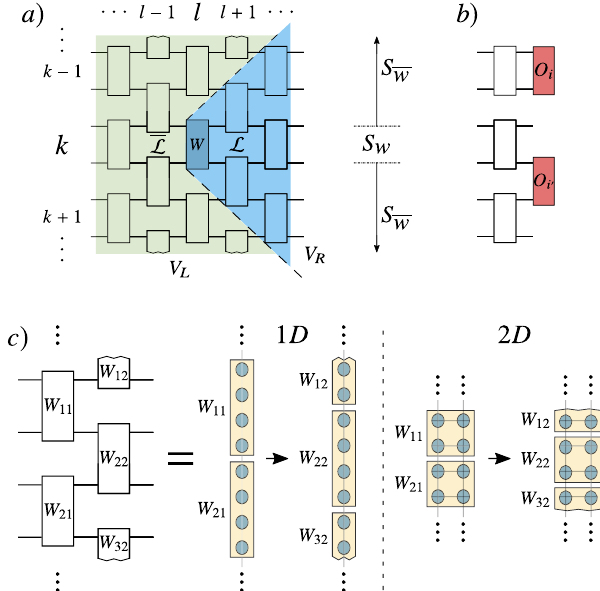
Fig. 3 Alternating Layered Ansatz. a Each block W kl acts on m qubits and is parametrized via (27). As shown, we de fi ne S k as the m -qubit subsystem on which W kL acts, where L is the last layer of V ( θ ). Given some block W , it is useful for our proofs (outlined in the Methods) to write V ð θ Þ ¼ V 1 W Þ V V w (cid:4) R contains all gates in the forward light- R ð L , where cone L of W . The forward light-cone L is de fi ned as all gates with at least one input qubit causally connected to the output qubits of W . We de fi ne L as the compliment of L , S w as the m -qubit subsystem on which W acts, and S n − m qubit subsystem on which W acts trivially. b The operator w as the O S O i acts nontrivially only in subsystem k (cid:2) 1 2 S , while i 0 acts nontrivially on the fi rst m /2 qubits of S k + 1 , and on the second m /2 qubits of S k . c Depiction of the Alternating Layered Ansatz with one- and two-dimensional connectivity. Each circle represents a physical qubit.